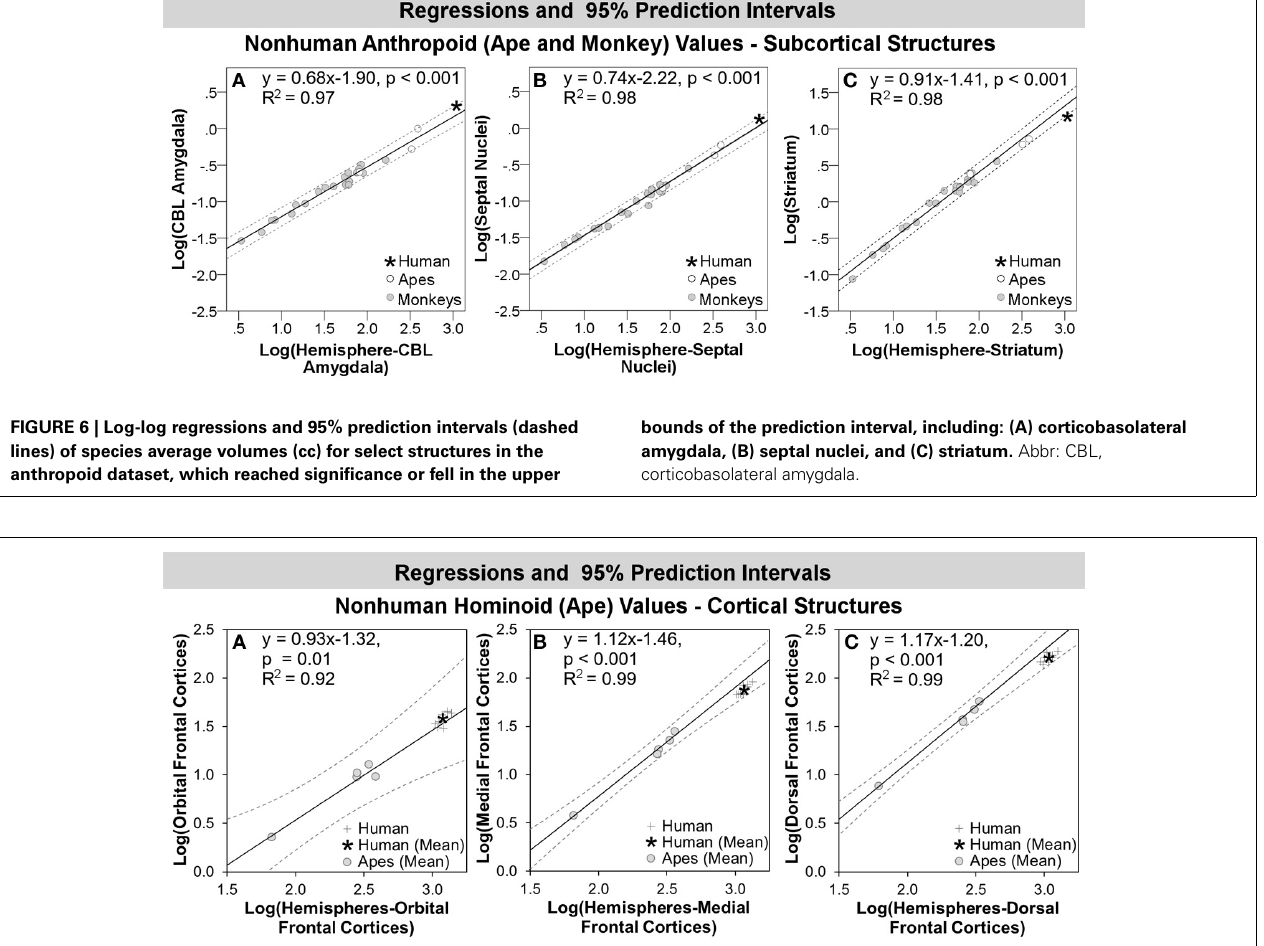
FIGURE 7 | Log-logregressionsand95%predictionintervals(dashedlines)ofspeciesaveragevolumes(cc)forselectcorticalstructuresinthehominoid dataset, which reached significance in statistical analyses, including: (A) orbital frontal cortex, (B) medial frontal cortex, and (C) dorsal frontal cortex.